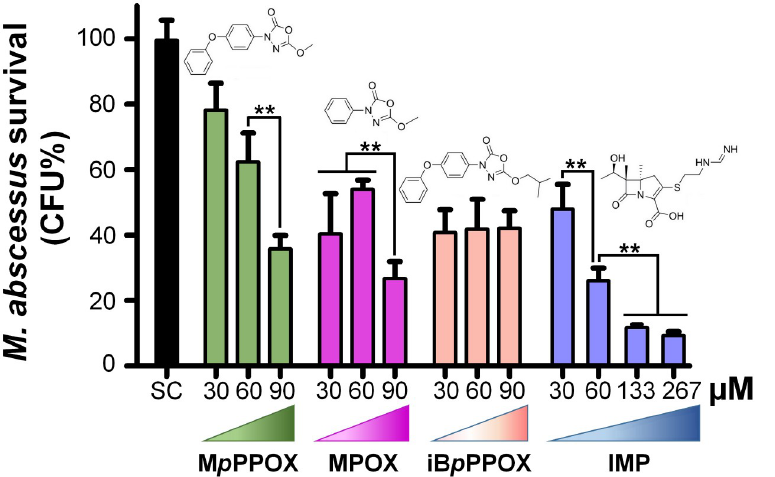
Fig 2. Intracellular activity of M p PPOX, MPOX and iB p PPOX as compared to imipenem (IMP). The activity of selected OXs on intracellular M . abscessus was tested in Raw264.7 murine macrophages. Cells were infected at a multiplicity of infection (MOI) of 10:1 with M . abscessus S variant and treated with various concentrations of each inhibitor or IMP for 24 h. Then, surviving bacteria were enumerated by plating serial dilutions of macrophage lysates. DMSO-treated infected macrophages ( i . e ., SC, solvent control) were used as control representing 100% of bacterial viability. Results are shown as mean ± standard error of the mean (SEM) of three independent assays performed in triplicate. �� , p -value < 0.01. � , p -value < 0.05. Statistical analysis was done using a Student’s t